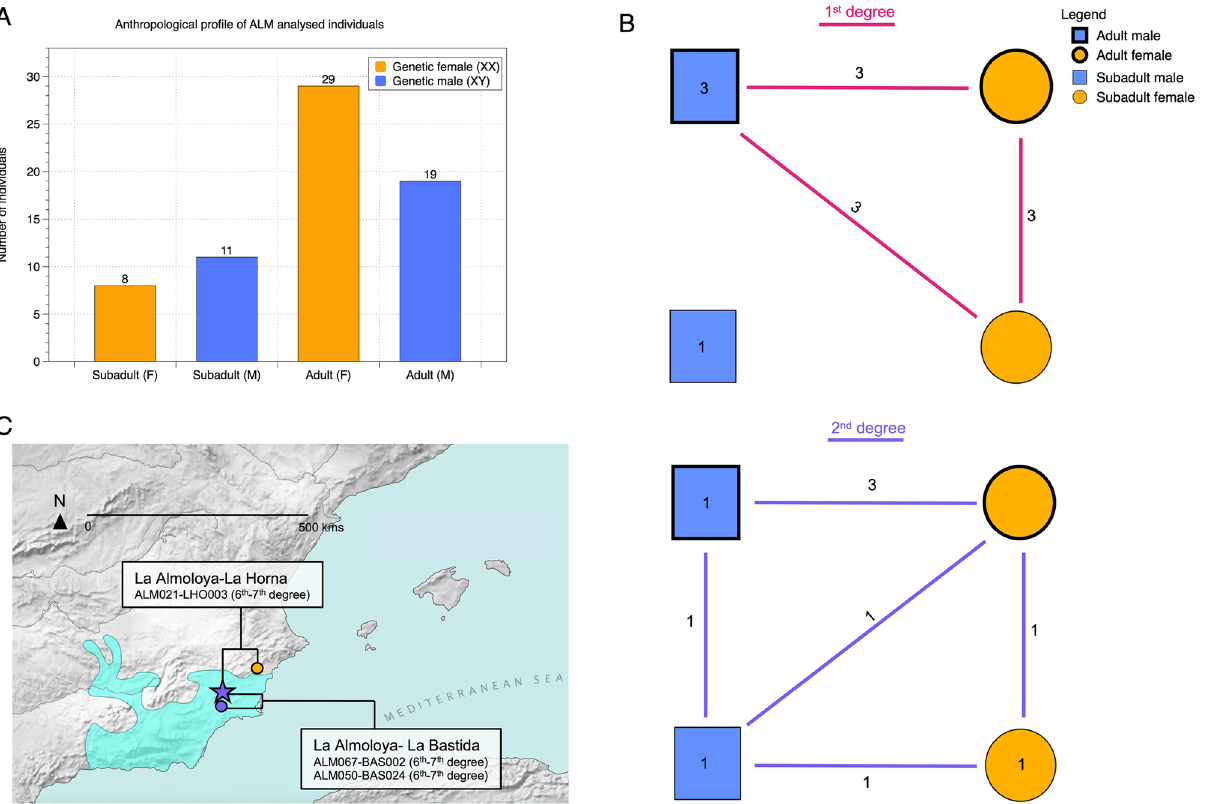
Figure 4. Overview of genetic sex and age at death determinations and total numbers of observed relationships per category and long-distance relatives outside La Almoloya. ( A ) Simplified age classes of the individuals analyzed from La Almoloya: subadult (including infant (0–3 years) and child (3–12 years)) and adult (including young adult (20–35 years), middle adult (35–50 years), and old adult (50+ years) 56 ) females and males. Of note, adolescent individuals (12–20 years) were not found at the site; ( B ) total number of 1st- (pink) and 2nd-degree (purple) relatives between age and sex classes as summarized in ( A ). Numbers reflect the number of links in the pedigrees between age/sex classes and numbers inside symbols reflect the number of links within each class. The graph illustrates the absence of either 1st- or 2nd-degree relationships among adult females; ( C ) Long-distance relatives (6–7th degree) as indicated by shared IBD-blocks between individuals from La Almoloya and other BA archaeological sites. The map was created using QGIS 3.12 (https:// qgis. org/ en/ site/) and uses Natural Earth vector map data from (https:// www. natur alear thdata. com/ downl